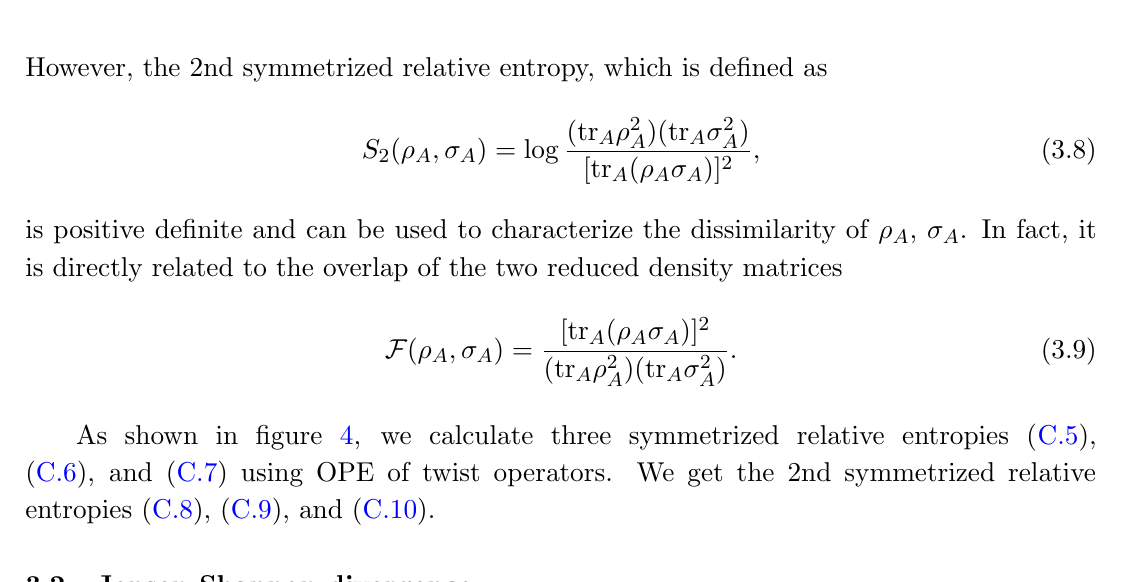
Figure 4. The 27 symmetrized relative entropies we can calculate using OPE of the twist operators. We only need to calculate the three ones marked in blue. This (cid:12)gure also applies to the 2nd symmetrized relative entropy, Jensen-Shannon divergence, as well as the Schatten 2-norm and 4- norm in the following